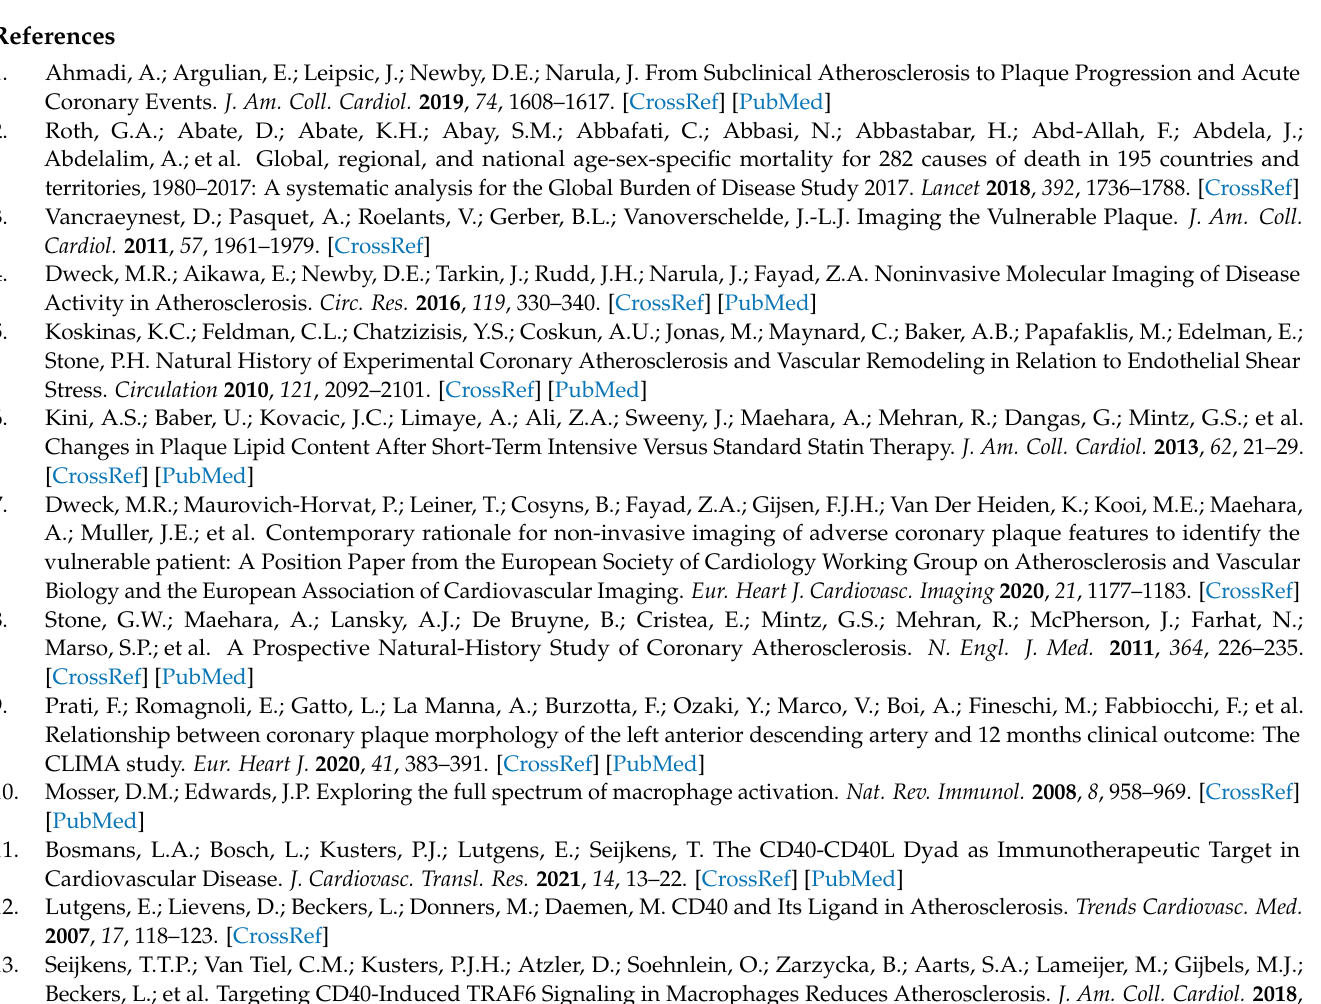
at 280 nm. Table S1. PET imaging quantifications of [ 89 Zr]Zr-anti-CD40 mAb at day 3 p.i. in WT and ApoE − / − mice. Table S2. PET imaging quantifications of [ 89 Zr]Zr-anti-CD40 mAb at day 7 p.i. in WT and ApoE − / − mice. Table S3. Ex vivo biodistribution of [ 89 Zr]Zr-anti-CD40 mAb at day